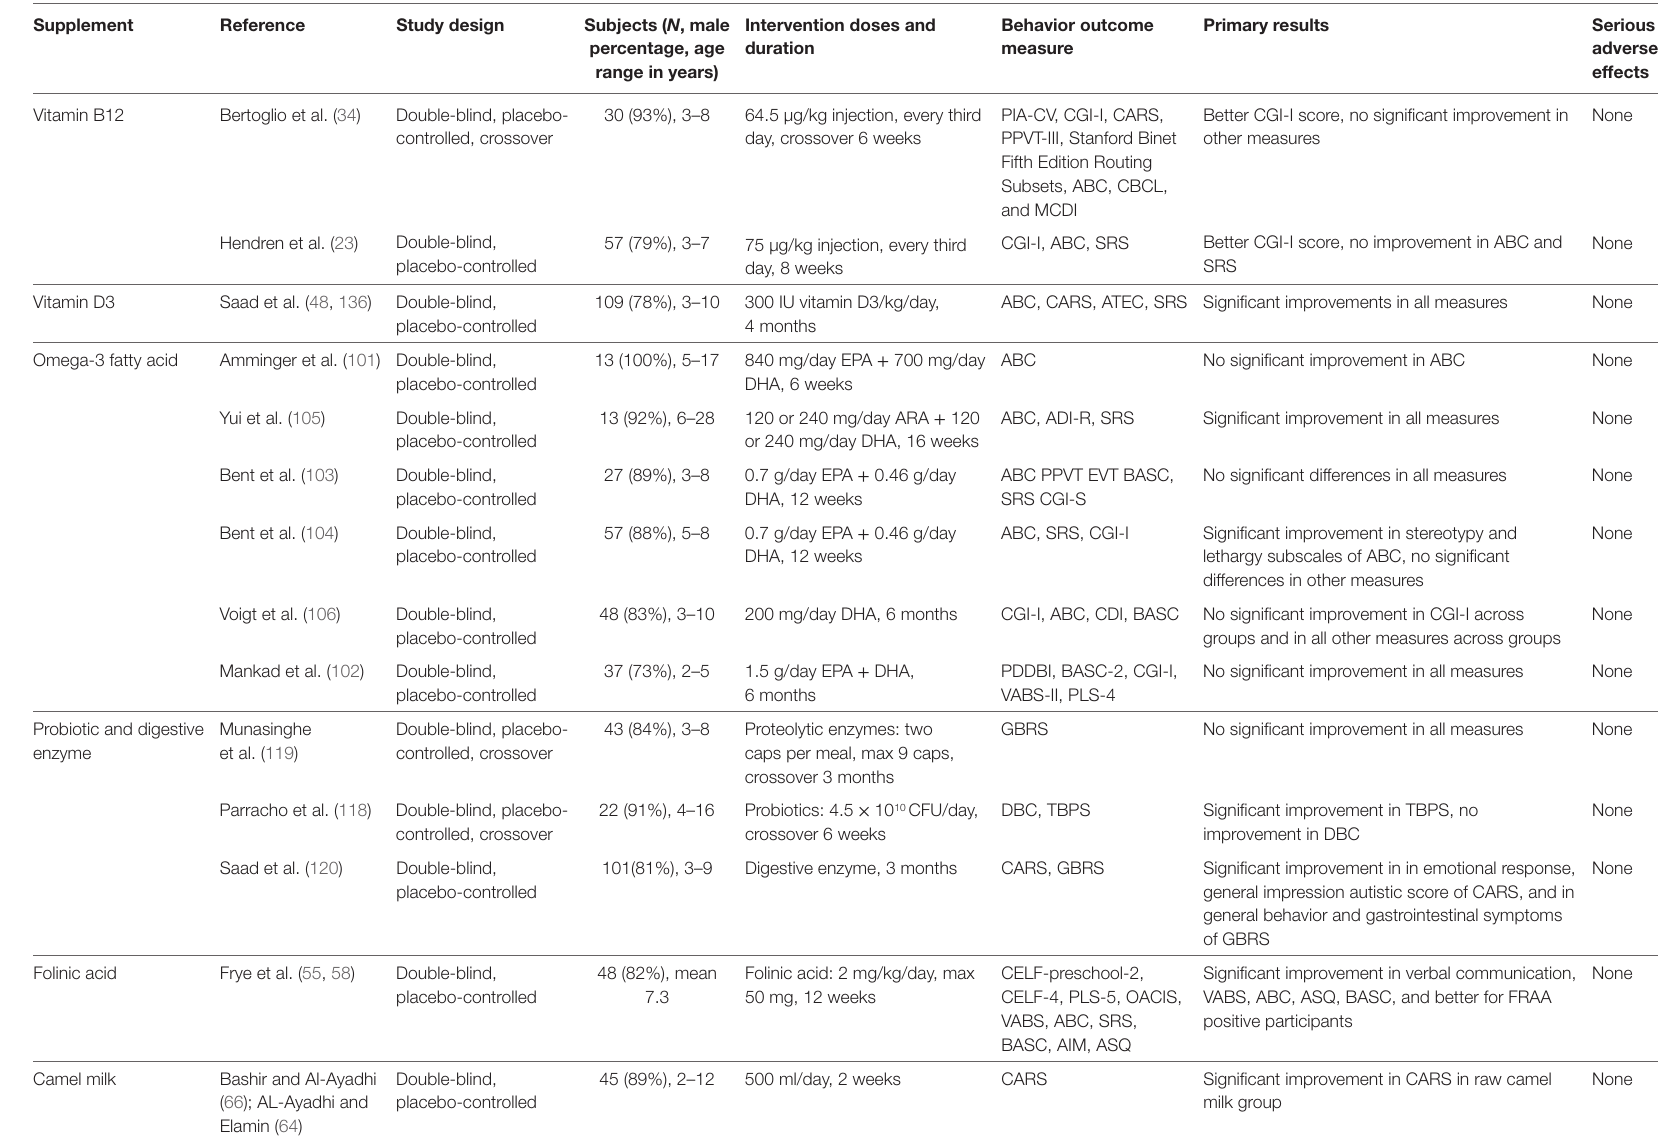
TABLe 1 | Summary of published randomized controlled trials of dietary supplement interventions for ASD.